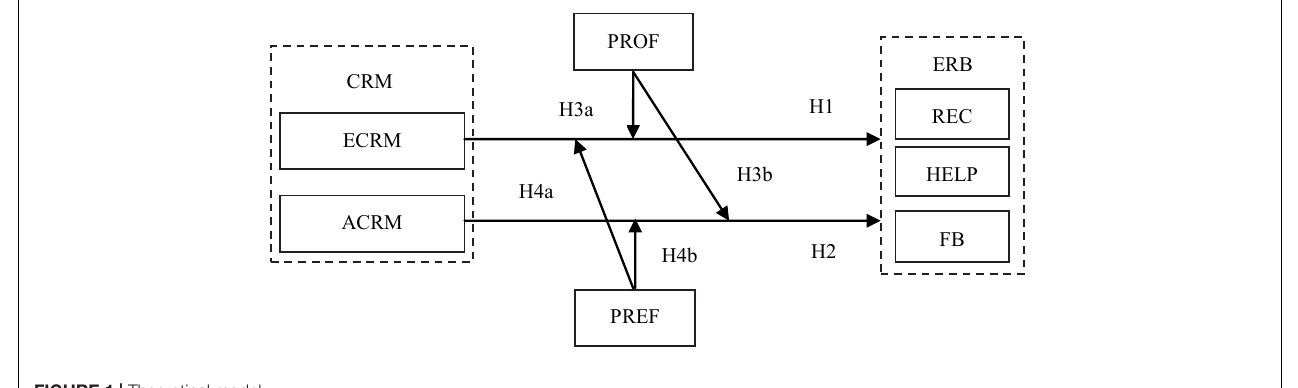
FIGURE 1 | Theoretical model.